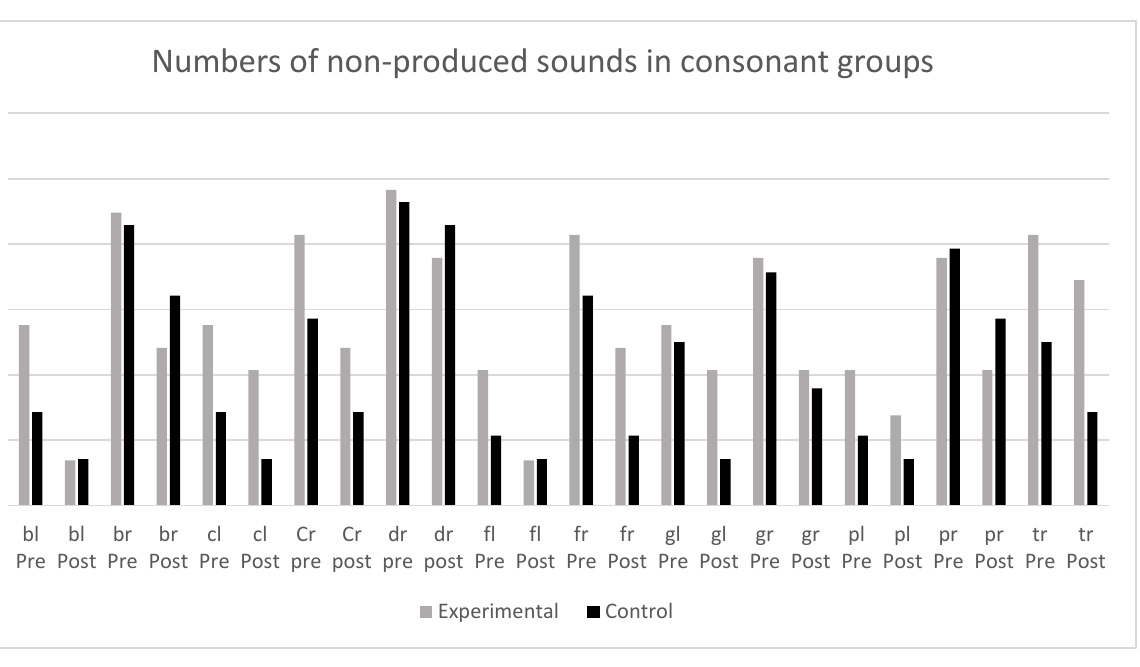
Figure 3. Number of non-produced sounds in consonant groups in the pretest and post-test in experimental and control groups.